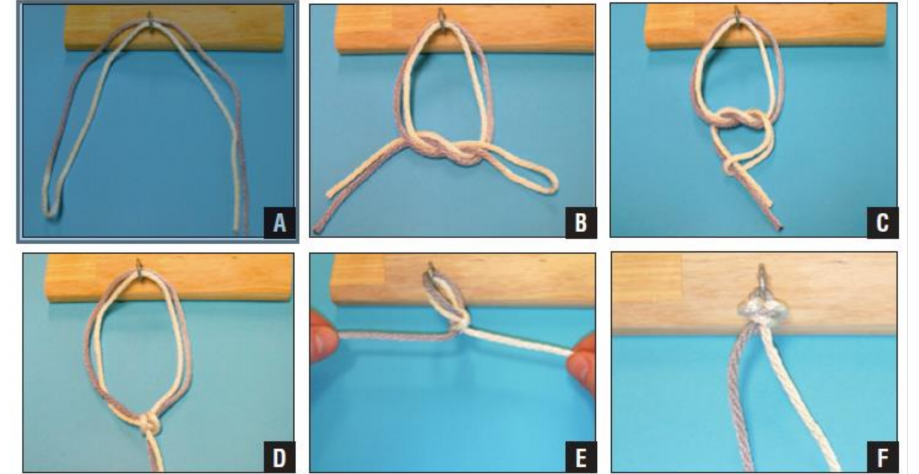
Figure 2. Nice Knot technique. ( A ) A double-over suture is threaded around the tissue. ( B ) A single square knot is thrown. ( C ) The two free limbs are passed through the loop. ( D ) The knot is dressed. ( E ) The knot is tightened by pulling the two free limbs apart. ( F ) Three half-hitches are applied to secure the knot. Reprinted with permission from [88]. Copyright 2017. SLACK R